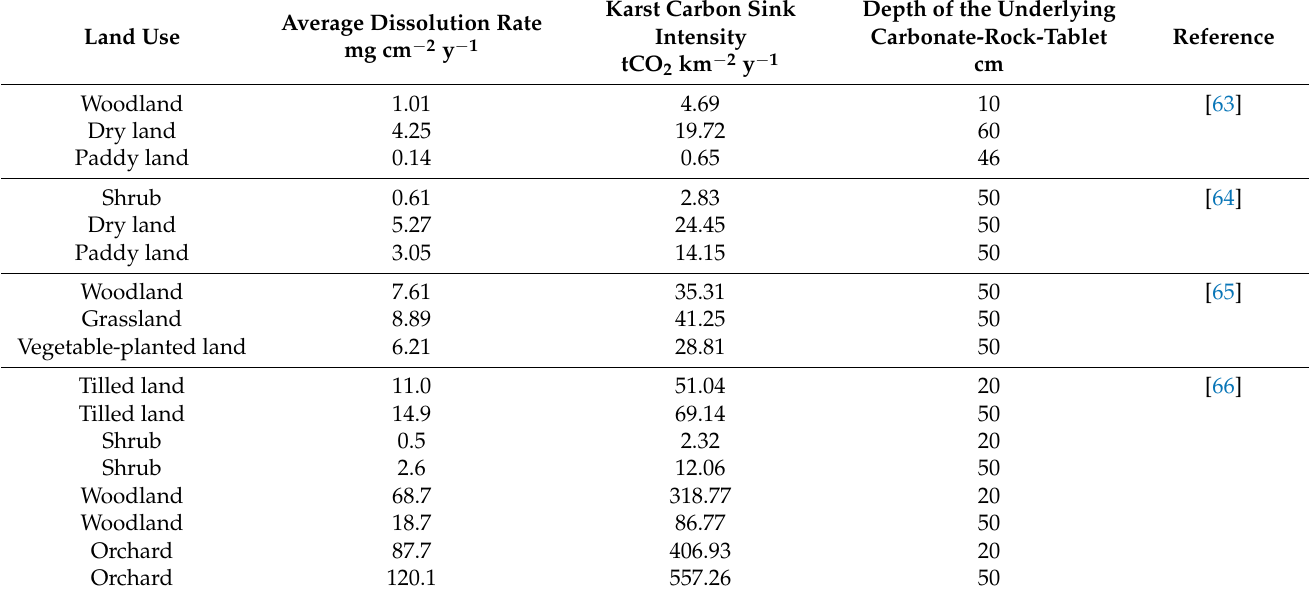
Table 1. Dissolution of different land use types.